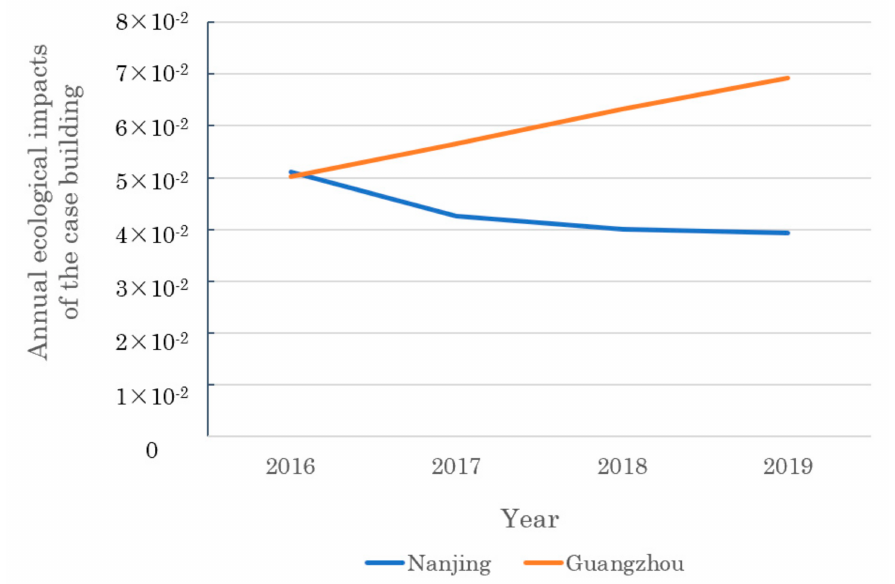
Figure 5. Annual ecological impacts of the case building (per m 2 ) in Nanjing and